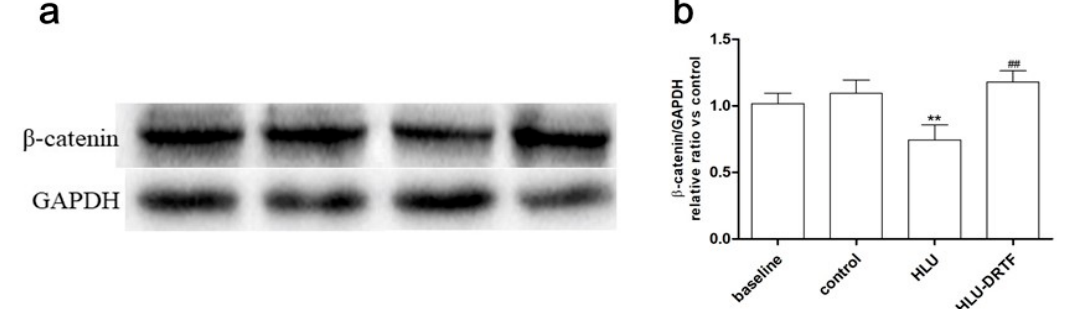
Figure 4. The protein expression of β -catenin in baseline, control, HLU and HLU–DRTF groups. ( a ) western blot analysis of β -catenin expressions in different groups; ( b ) “Quantity one” from Bio-Rad was used to analyze the western blotting results. The values were expressed as mean ± SD ( n = 3), ** p < 0.01 vs. control, ## p < 0.01 vs. HLU.